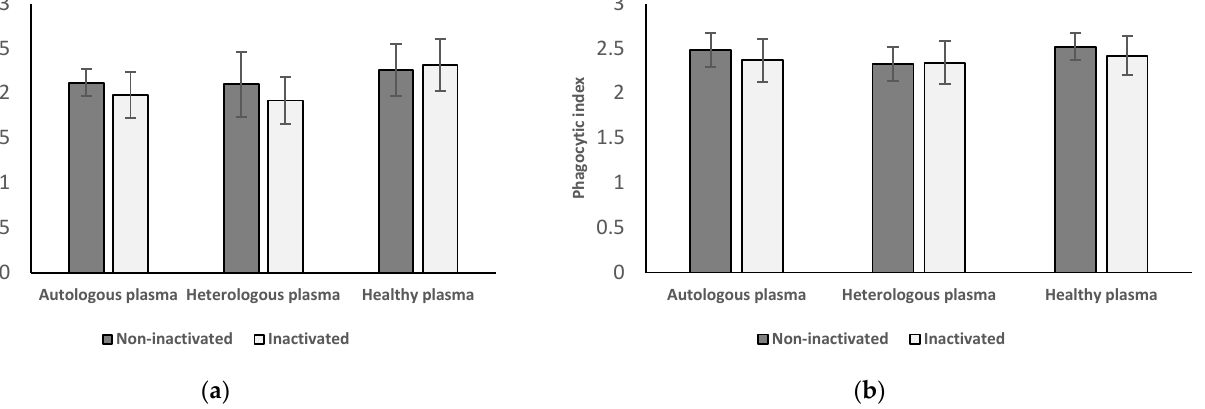
Figure 4. Phagocytic index of neutrophil granulocytes ( a ) and monocytes ( b ) of women with endometriosis after surgery followed by the treatment with autologous and heterologous plasma from the same group of patients and with plasma from healthy women. Experiments were performed with inactivated and non-inactivated plasma samples in each group. No significant difference was found between the groups.